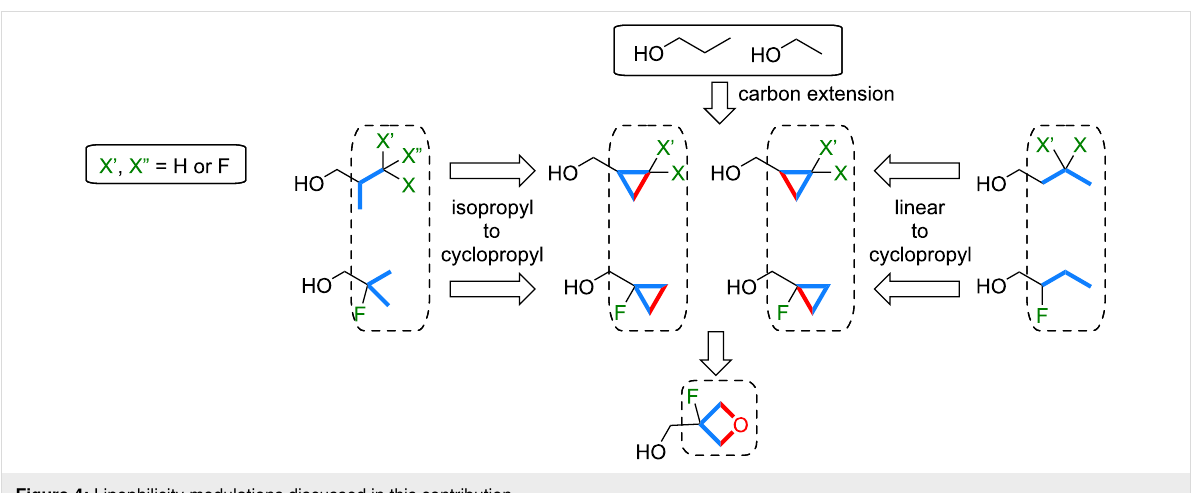
Figure 4: Lipophilicity modulations discussed in this contribution.